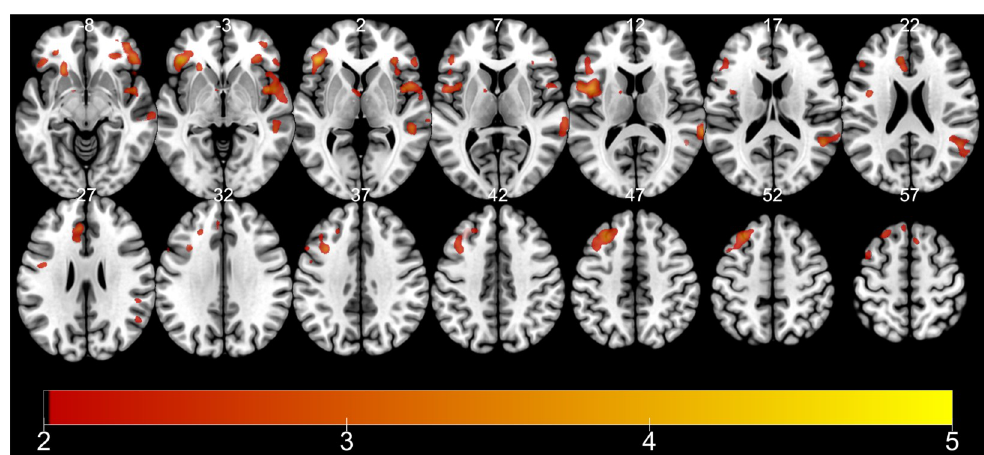
Fig 5. fMRI results (encoding). IE: SME proportionate to TD when retrieved remotely. Color bar indicates t-statistics.